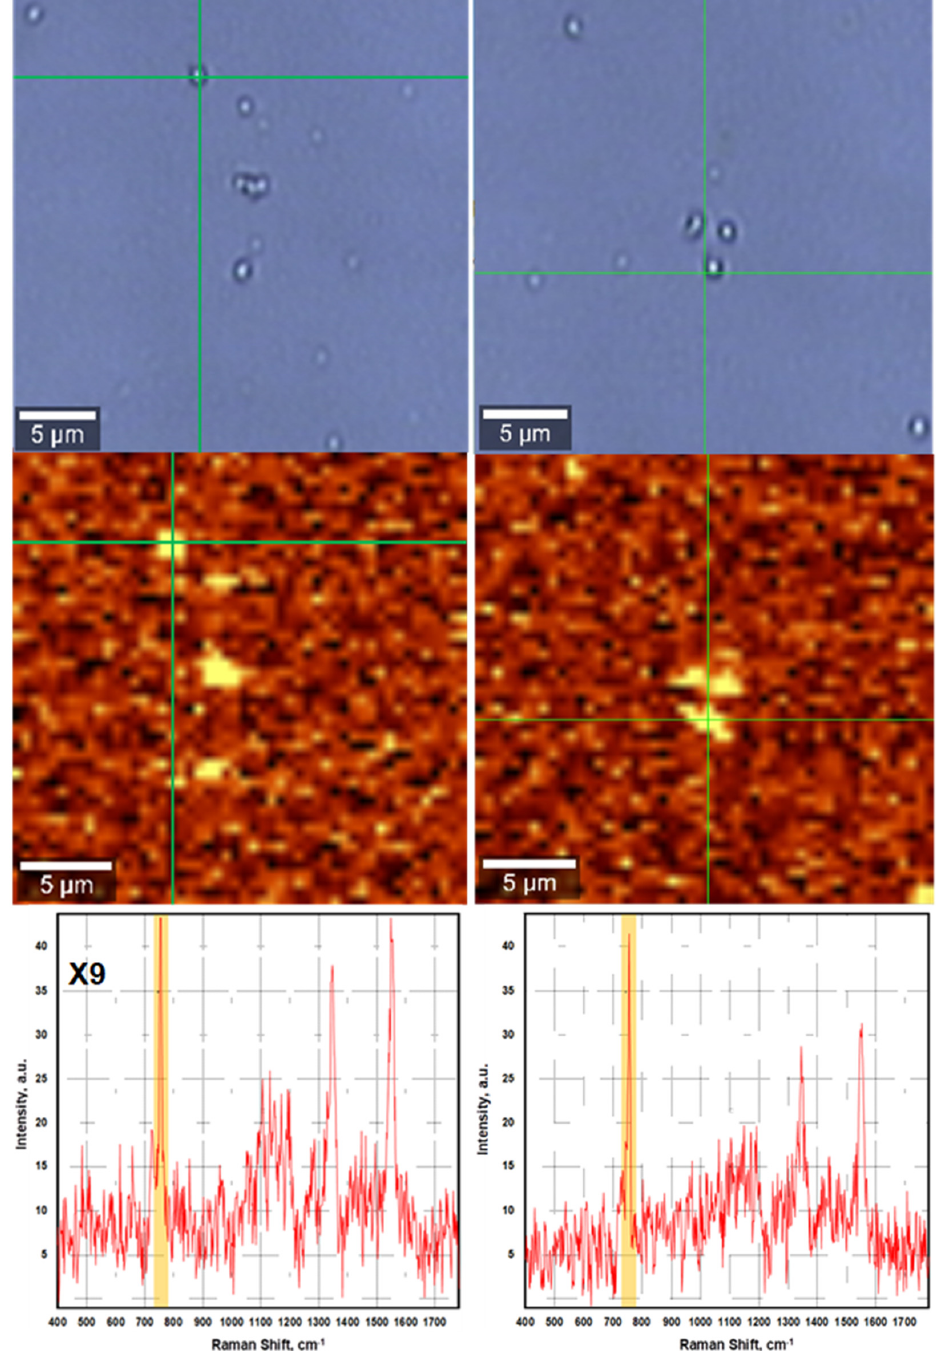
Figure 5. SERS-mapping of a sample of the RBD protein with reduced disulfide bonds. Finding and SERS-mapping a sample of the RBD protein with reduced disulfide bonds applied onto the metal surface of the SERS-active substrate (the left column) and with an additional silver layer applied above (the right column). The upper panels show images in the wide-field upright optical microscopy mode. The middle panels show the confocal SERS-mapping in the characteristic band of the tryptophan line at about 755 cm − 1 for subsequent recording of the SERS spectrum at the point indicated by the green cross (the lower panels). The scaling factor for the spectrum in the left lower panel is 9.